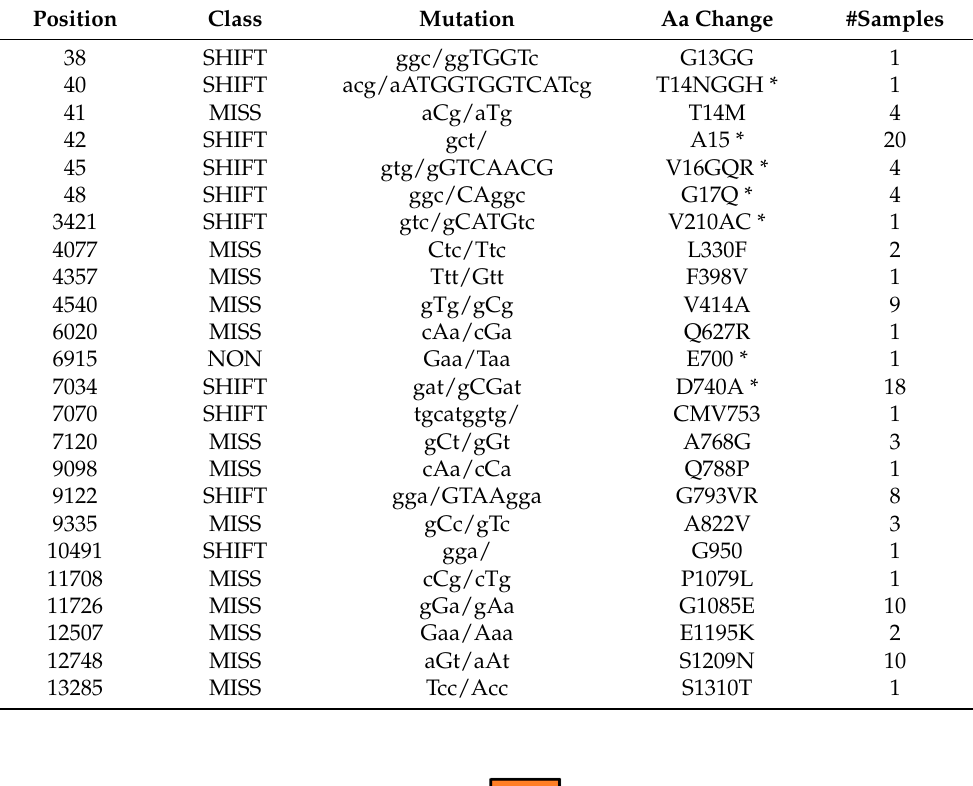
Table 2. Nonsynonymous and frameshift mutations identified by SnpEFF across 41 S. frugiperda SfABCC2 bi-allelic variants. The nucleotide position in the SfABCC2 gene reference (Position), the functional class of mutation (MISS = missense, NON = nonsense, and SHIFT = frameshift), the mutation with capitalized reference and alternative alleles, the corresponding amino acid change (Aa change), and the number of samples positive for that mutation (#Samples) are shown. Asterisks denote that the mutation leads to a premature stop codon. The SfABCC2mut allele is synonymous with D740A.